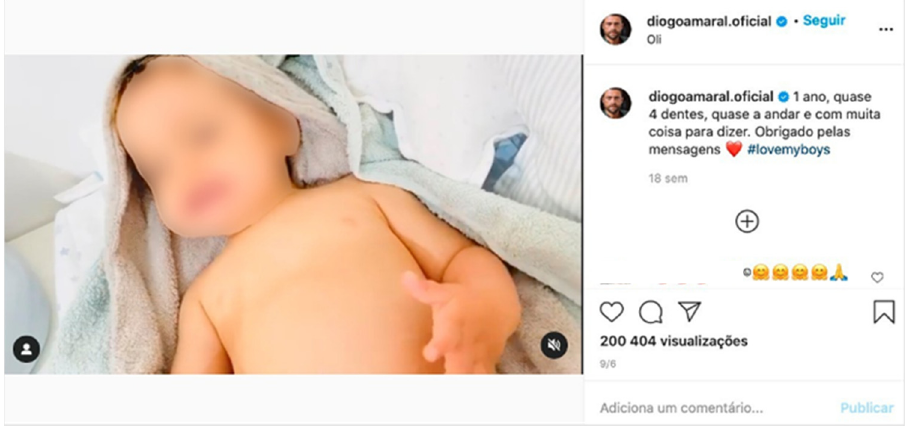
Figure 10. Example of speech “Information about the child”; @diogoamaral.oficial, Post, 9 June 2020.